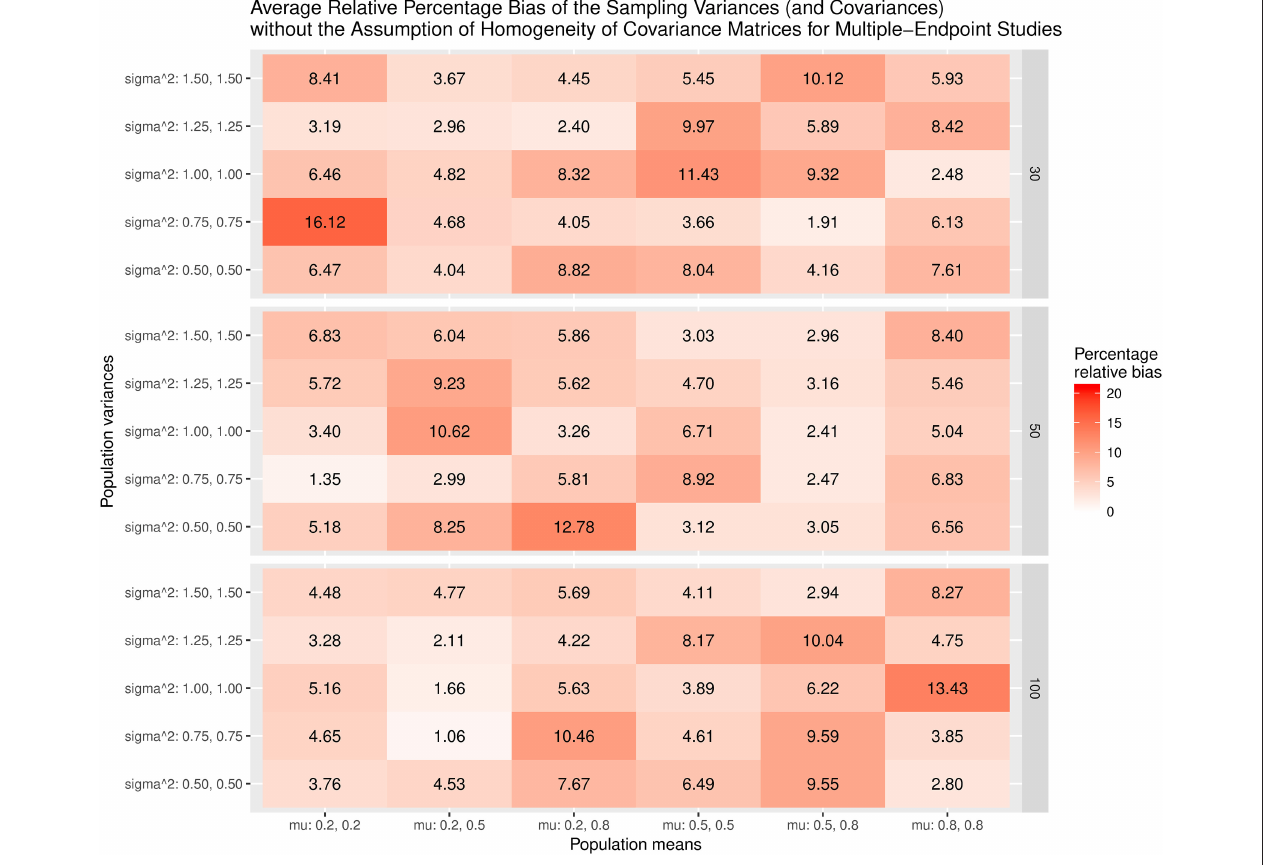
Frontiers in Psychology |